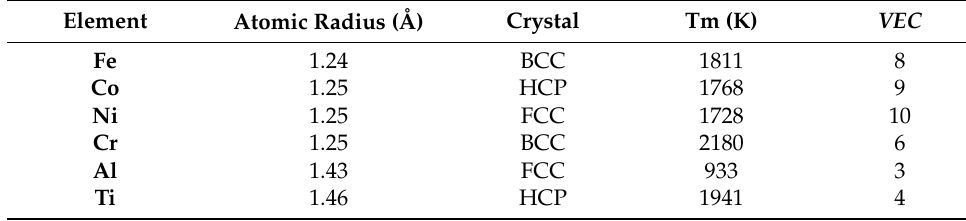
Table 2. Thermophysical parameters of elements in HEAs [26,30].